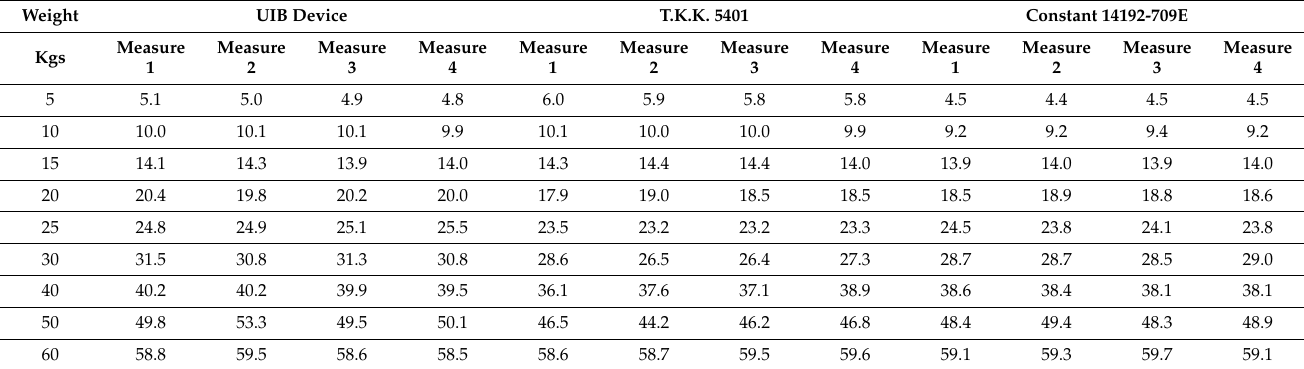
Table 1. Measurement table with calibration load and display dynamometer value.